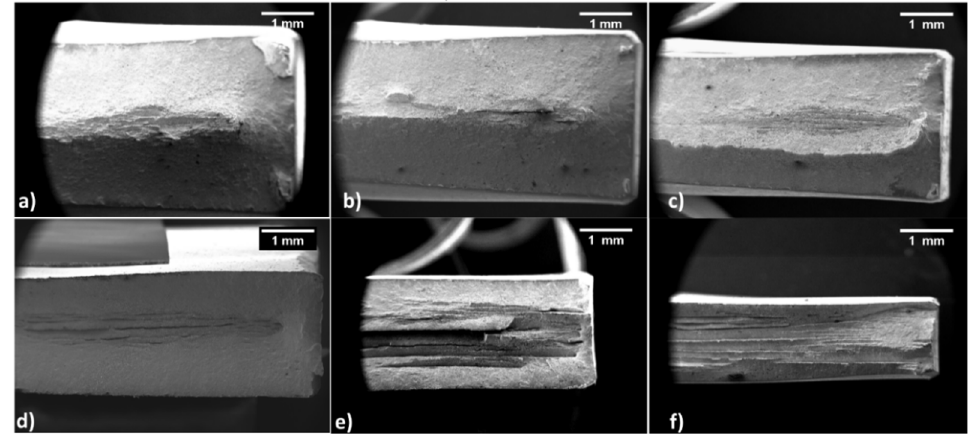
Figure 12. Fractured surface of longitudinal samples with increasing work hardening levels of ( a ) Figure 13. Fractured surface of transversal samples with increasing work hardening levels of: ( a ) 20, 20%, ( b ) 30%, ( c ) 40, ( d ) 50%, ( e ) 60% and ( f ) 70%. ( b ) 30, ( c ) 40, ( d ) 50, ( e ) 60 and ( f ) 70%.